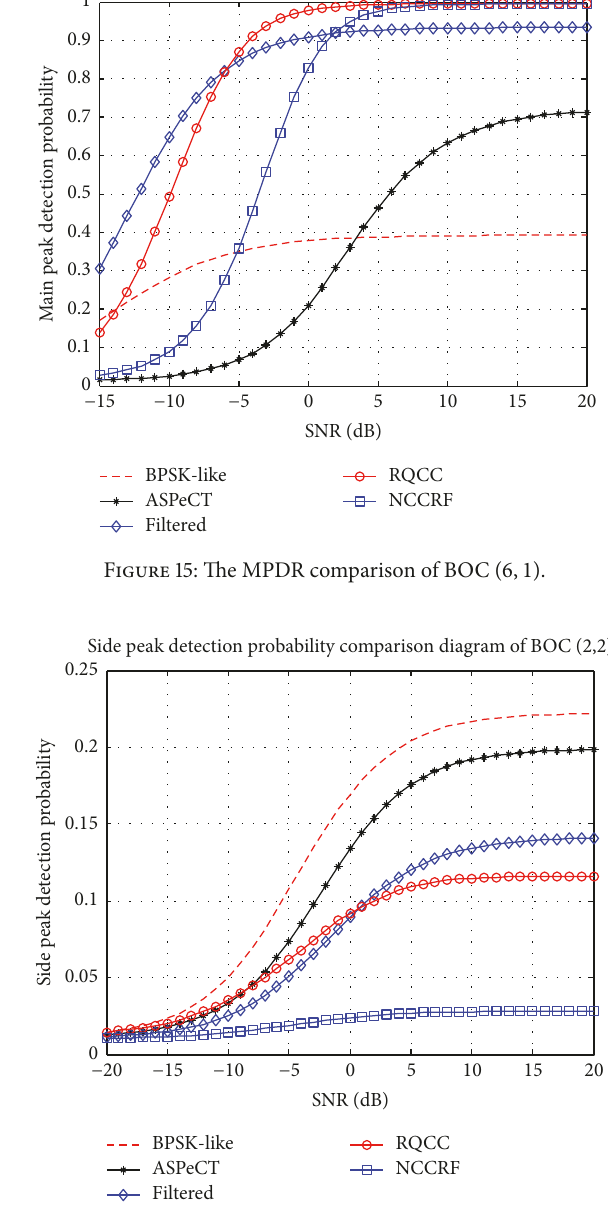
Figure 16: The SPDR comparison of BOC ( 2,2